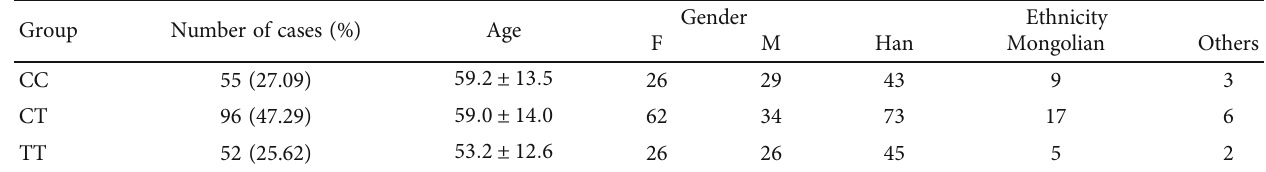
Table 1: Patient baseline characters.